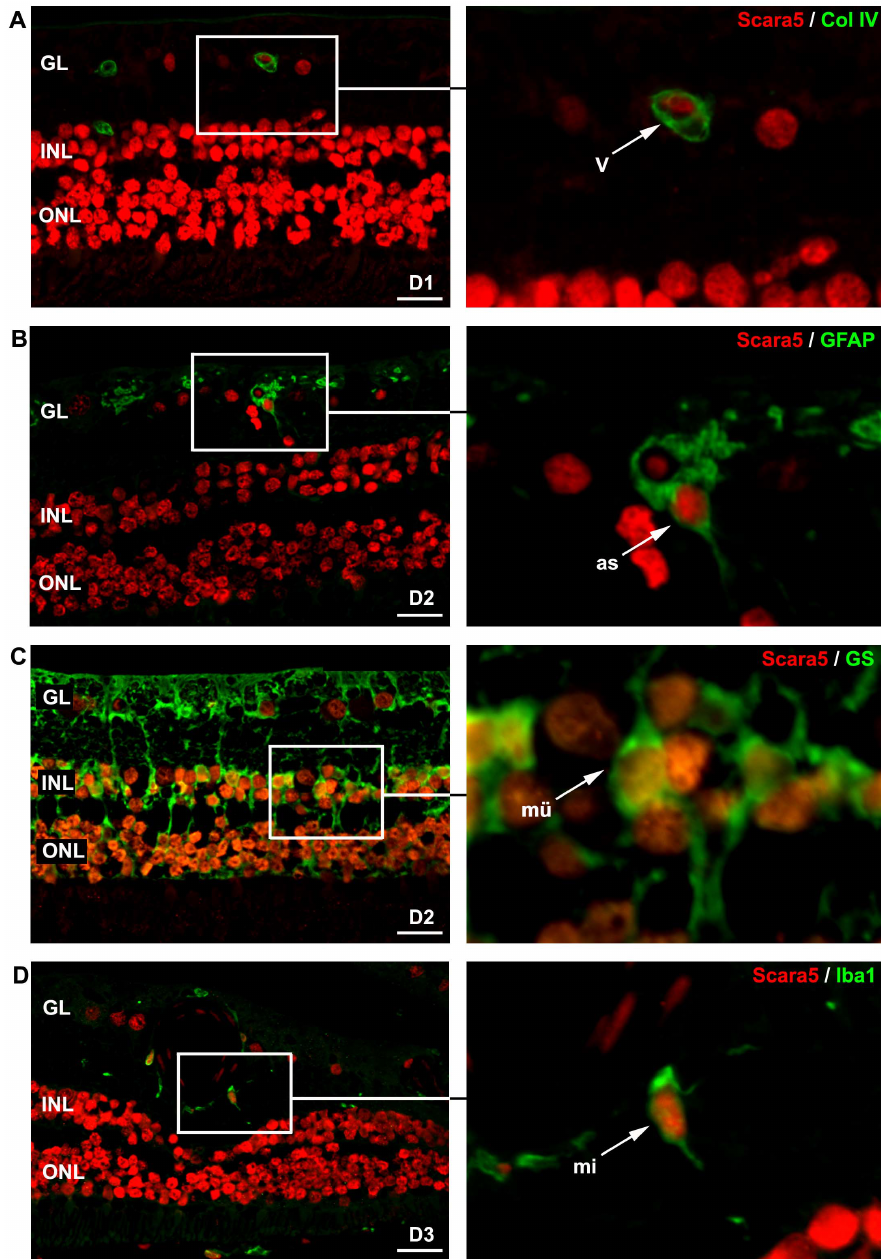
Figure 11. Scara5 was expressed in human retinal cells. Laser confocal analysis of double-stained paraffin-embedded human retinal sections with anti-Scara5 and anti-collagen IV, anti-GFAP, anti-GS and anti-Iba1 antibodies revealed that Scara5 was present throughout the retina, including endothelial cells, astroctyes, Mu¨ller cells and microglial cells, following the distribution pattern observed in mouse retinas. D1, D2 and D3, 42, 78 and 86-years-old healthy human donors, respectively; GL, ganglion cell layer; INL, inner nuclear layer; ONL, outer nuclear layer.: 22 m m (A); 21 m m (B); 24 m m (C); 28 m m (D).